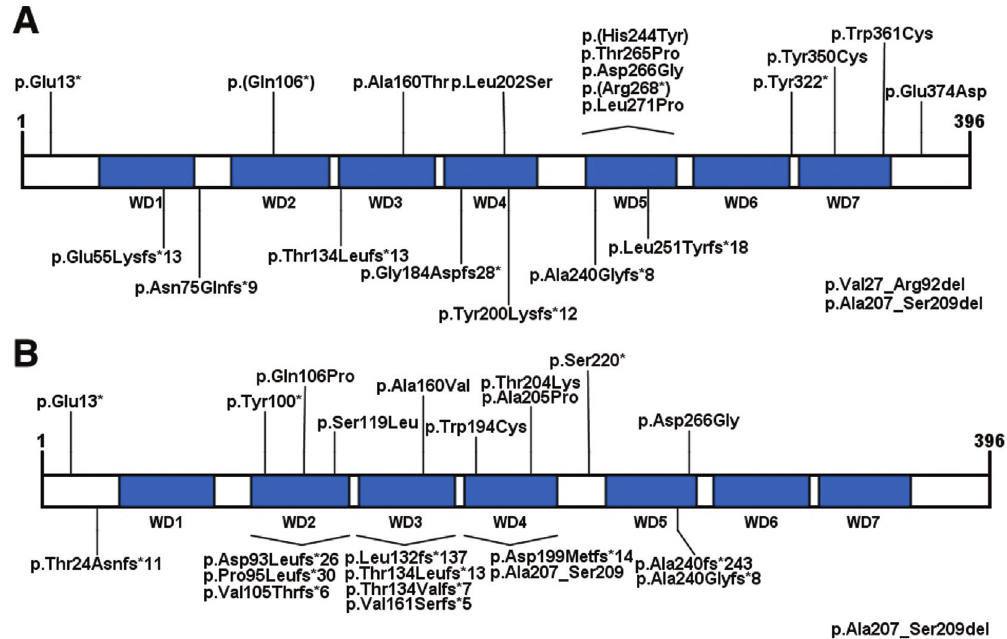
Figure 3 - Representation of CSA protein and its seven WD-repeat domains. (A) Homozygous mutations are indicated: frameshifts and nonsense muta- tions are indicated above the protein, while deletions and missense mutations are indicated below the protein. (B) Represents heterozygous